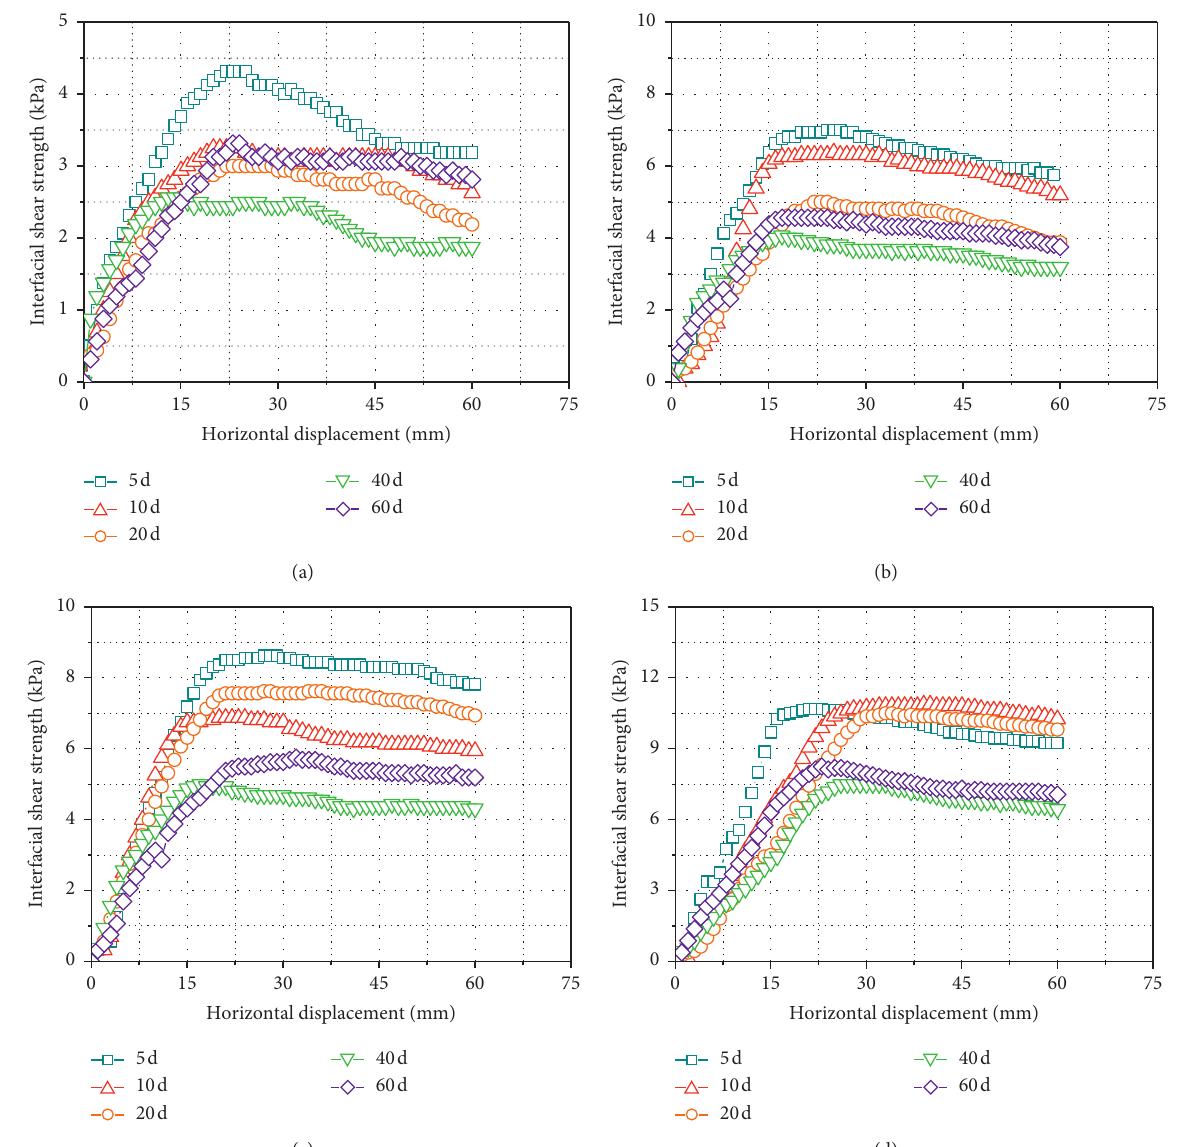
Figure 3: Curve of shear strength of interface with horizontal displacement under different immersion time. (a) 20kPa, (b) 40kPa, (c) 60kPa, and (d) 80kPa. Table 2: Peak values of interfacial shear strength. Normal stress Immersion time (d)